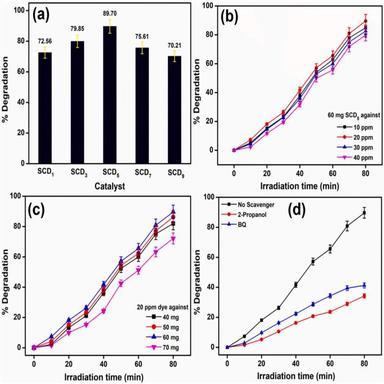
(a) % degradation of each (SCD1-9) catalyst against Rh–B dye, (b) Rh–B dye dosage effect on % degradation against 60 mg SCD5 catalyst, (c) catalyst dosage effect on % degradation against 20 ppm Rh–B dye, and (d) scavenger effect on % degradation of optimum 20 ppm Rh–B dye against 60 mg SCD5 catalyst.